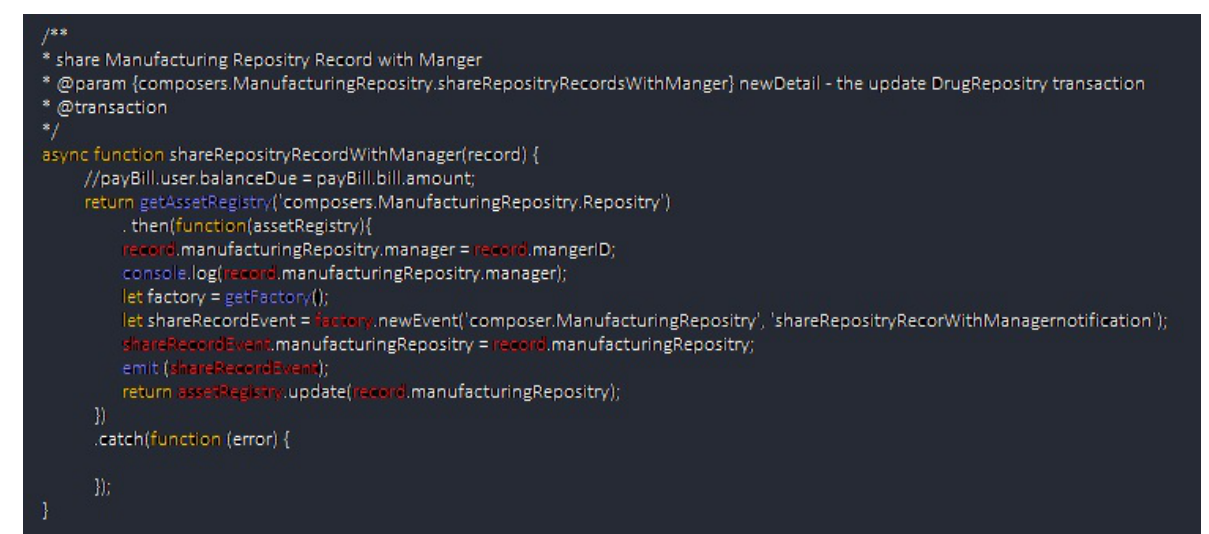
Figure 5. Transaction processor function in a manufacturing blockchain platform in the proposed manufacturing